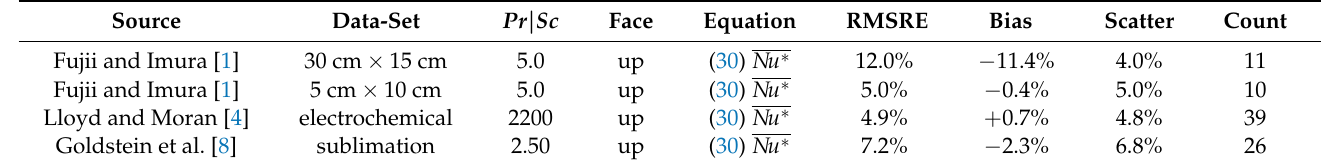
Table 3. Upward convection mass or heat transfer from horizontal